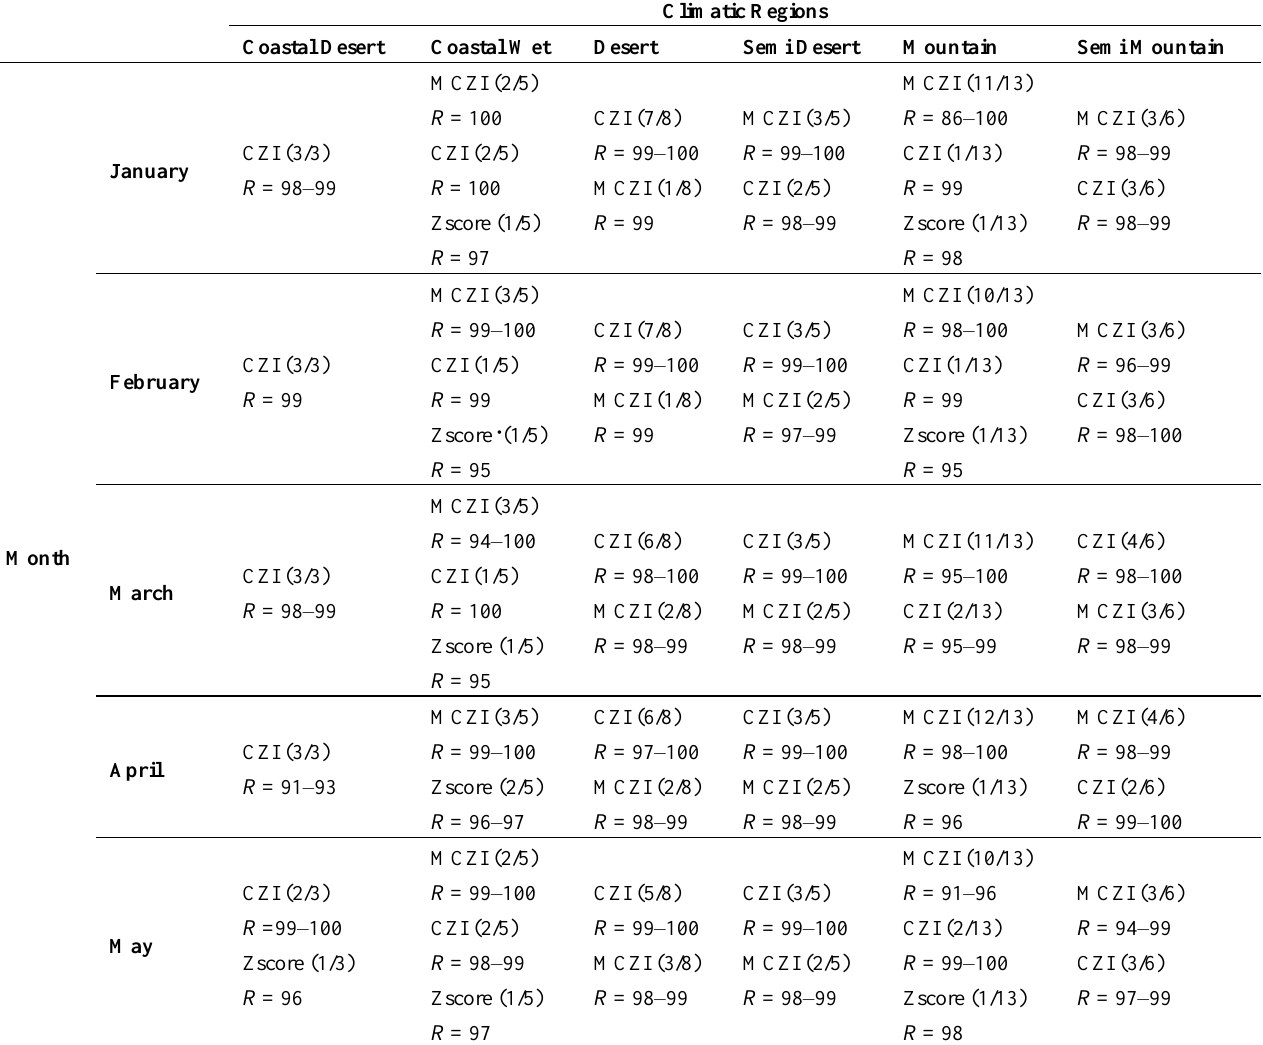
Table 3. The best indices according to region and time scale with the number of included stations per region in monthly